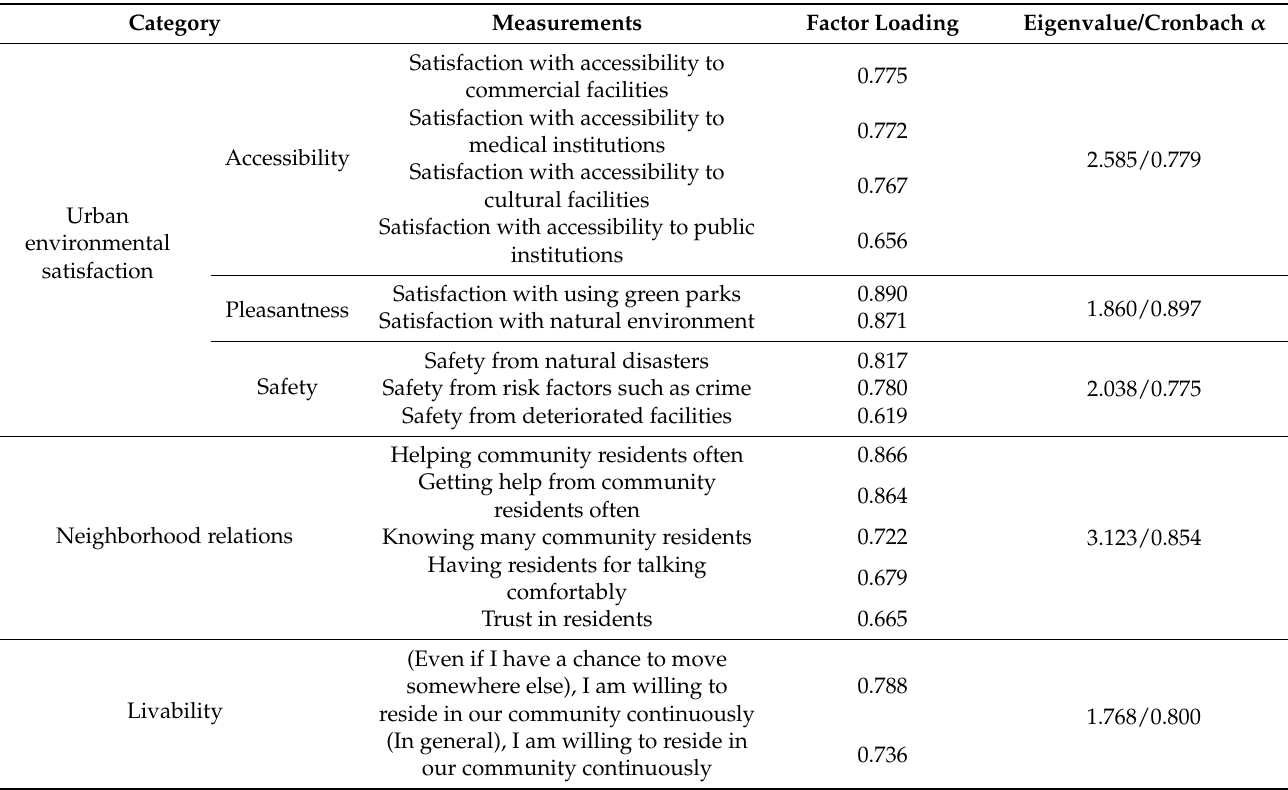
Table 2. Exploratory factor analysis (EFA) and reliability analysis.